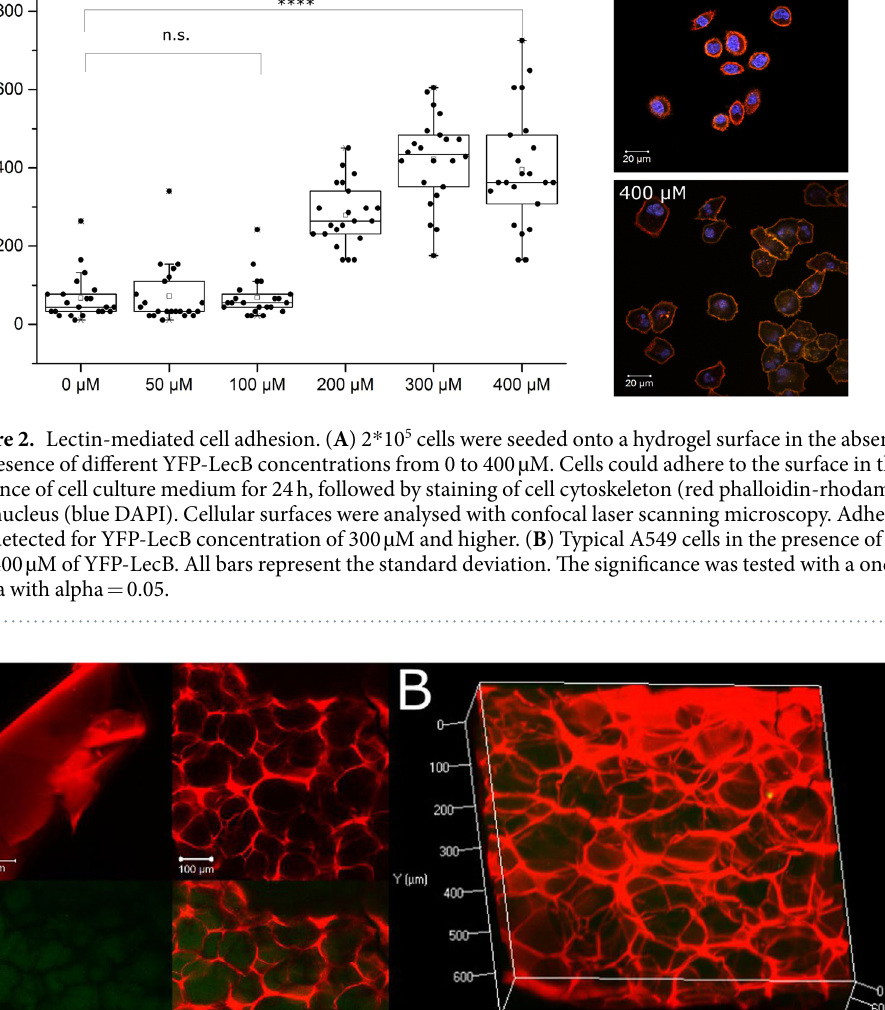
the cells onto the hydrogel. Whereas cells in the absence of YFP-LecB had a surface of less than 100 µ m 2 in aver- age, the YFP-LecB exposed cells showed surface areas increasing with the concentration of YFP-LecB up to more than 400 µ m 2 at concentrations higher than 300 µ M (Fig. 2 and Supplementary Fig. S2). Although, the analysis of the adhesion of A549 cells is difficult since it is known to differ strongly on different types of surfaces 35 the adhe- sion promoting influence of YFP-LecB is obvious. Furthermore, cells seeded onto the BSA hydrogel matrix as a control without lectin, easily detached from the surface by intense washing with PBS, which was not possible in the presence of YFP-LecB at concentrations higher than 100 µ M. Freeze-drying of hydrogels after polymerization was used to create simple 3D architectures 46, 47 . Ice crystal nucleation within the water-loaded environment of the material disrupts and replaces the initial hydrogel struc- ture and leaves a porous network after sublimation of the ice from the material. Figure 3A shows the native gel